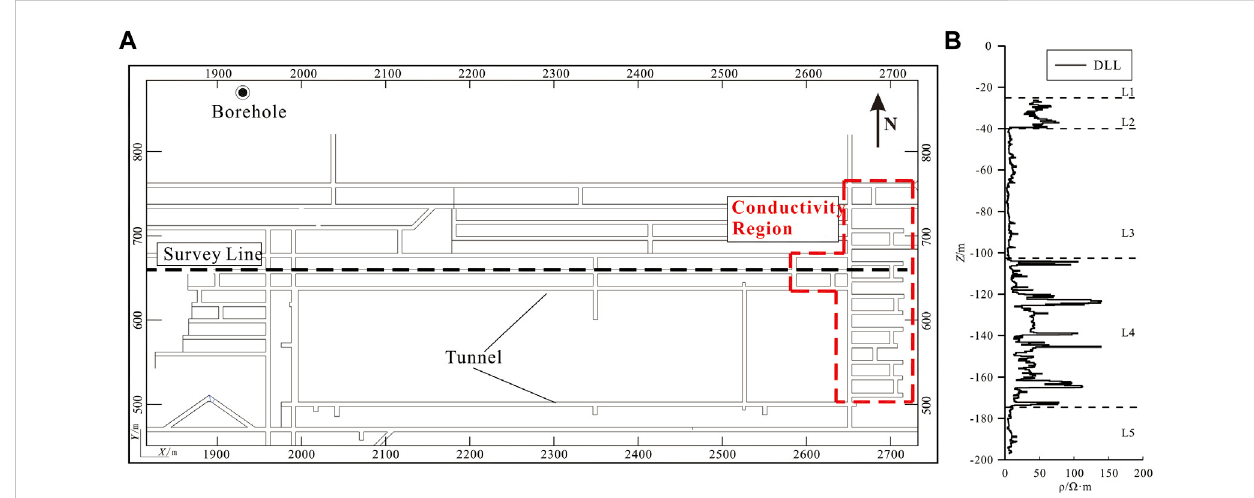
FIGURE 9 Priori information. (A) : Extraction engineering diagram. (B) : Borehole Dual Lateral Logging (DLL) data of